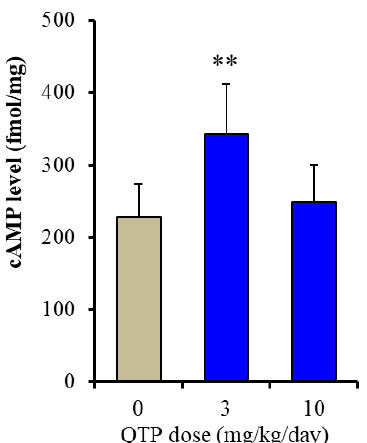
Figure 8. Effects of subchronically systemic administration of QTP on cAMP levels in the rat hypothalamus. Ordinates indicate mean ± SD (n = 6) of cAMP level in rat hypothalamus (fmol/mg). Abscissa: QTP dose (mg/kg/day). ** p < 0.01: relative to control (QTP free) by one-way ANOVA with Tukey’s post -hoc test.